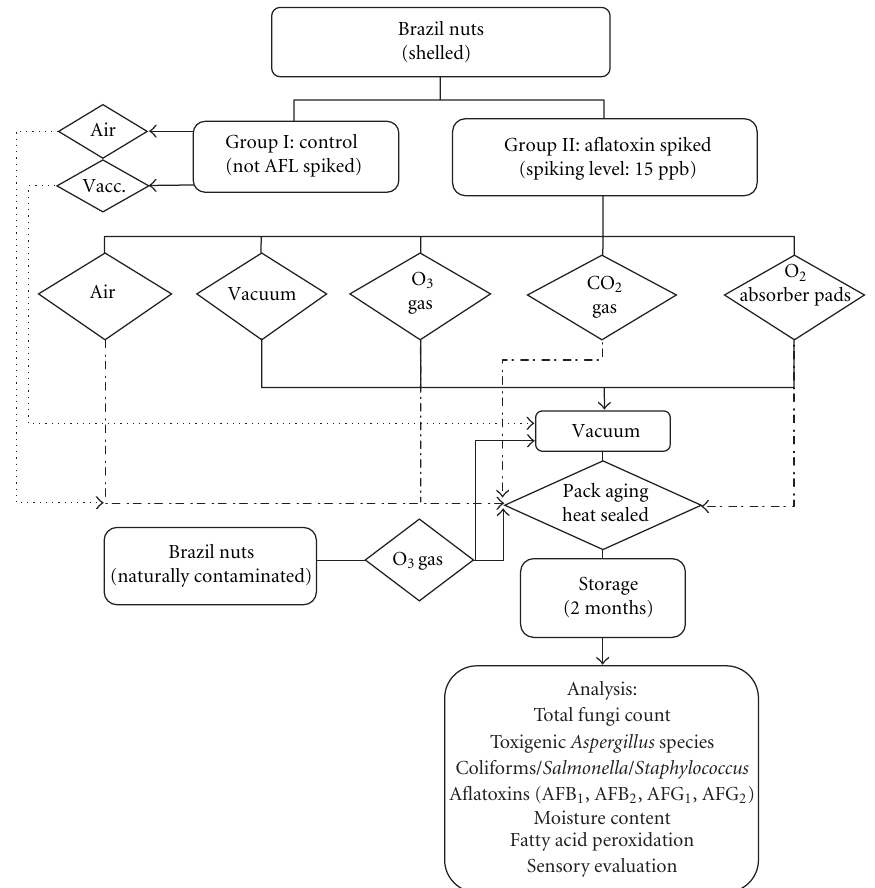
Figure 2: Chart flow of the oxygen-reducing atmospheres application on shelled Brazil nuts packs during